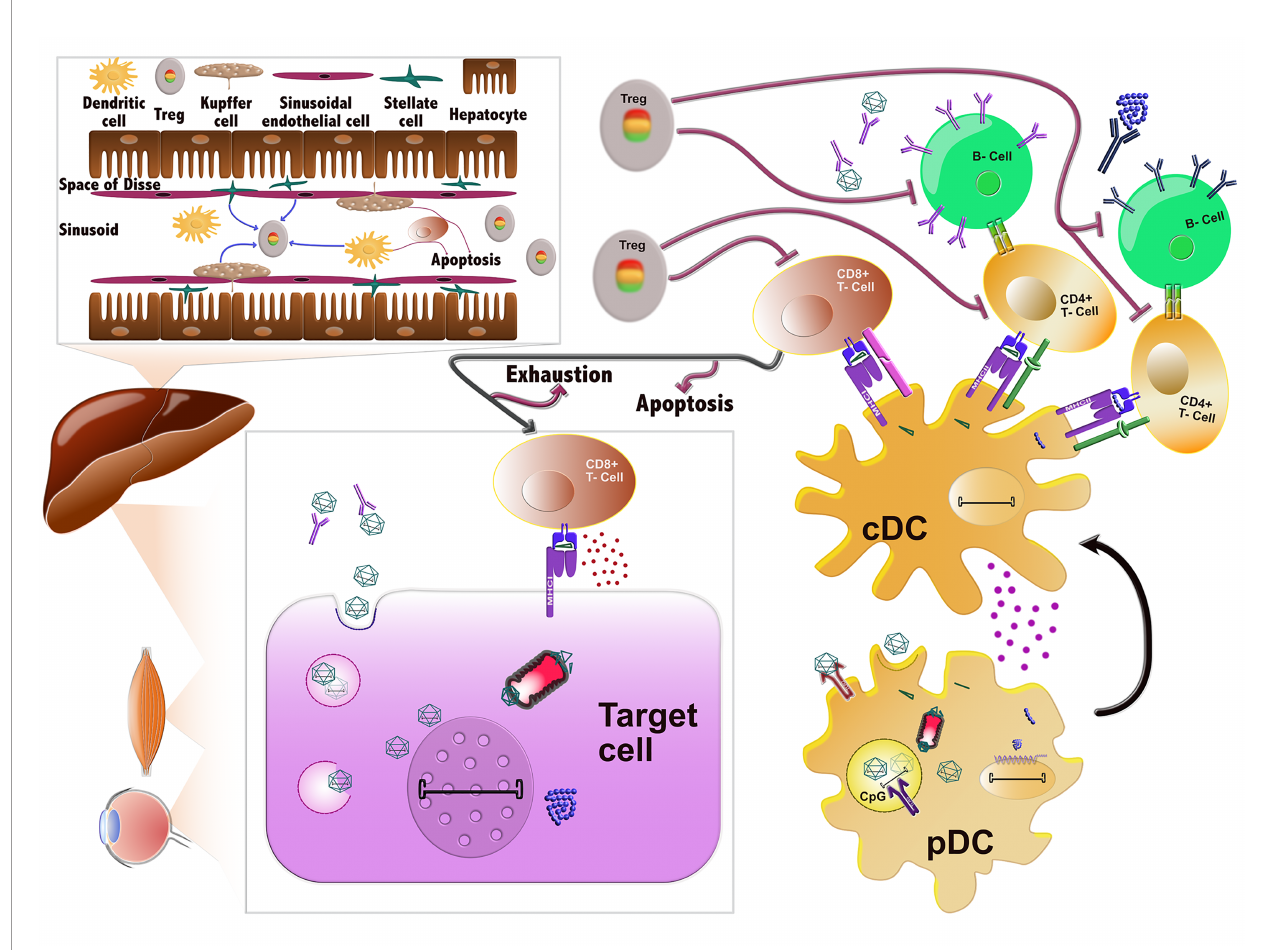
FIGURE 1 | Immune responses against AAVs. AAVs delivered systemically can be neutralized by pre-existing antibodies prior to entering the cells. If they evade nAb binding, they enter the cells through endocytosis and can then be degraded in the endosomes. In certain cell types, such as DCs, their genome or capsid can be sensed by TLR9 and TLR2, respectively, which induces the innate immune response. Alternatively, AAVs can successfully escape the endosome and traf fi c in the cytoplasm, where they can be ubiquitinated, resulting in capsid degradation. The ensuing peptides can next be loaded to MHC class I molecules and presented on the surface of the cells, which are then targeted and possibly eliminated by CD8+ T-cells (CTL response). After endosomal escape, AAVs can also successfully transduce the cell and deliver their viral genome to the nucleus, where the transgene is expressed. Any misfolded protein encoded by the transgene can be degraded by the proteasome and the ensuing peptides can be loaded onto MHCI and also provoke a CTL response. Sensing of AAV vector components in plasmacytoid DCs (pDCs) by the innate immune system leads to the activation of conventional DCs (cDCs). cDCs employ antigen presentation to cross-prime CD8+ T-cells towards an effector type (Teff) and to activate CD4+ T-cells. The latter can activate B cells, which in turn produce the nAbs against the capsid and transgene product. After prolonged or inadequate stimulation, the CD8+ T-cells can be eliminated by different mechanisms including T-cell exhaustion, anergy or apoptosis. The tolerogenic environment in the liver can also stimulate the production of regulatory T-cells (Tregs), which can suppress the aforementioned immune responses at different